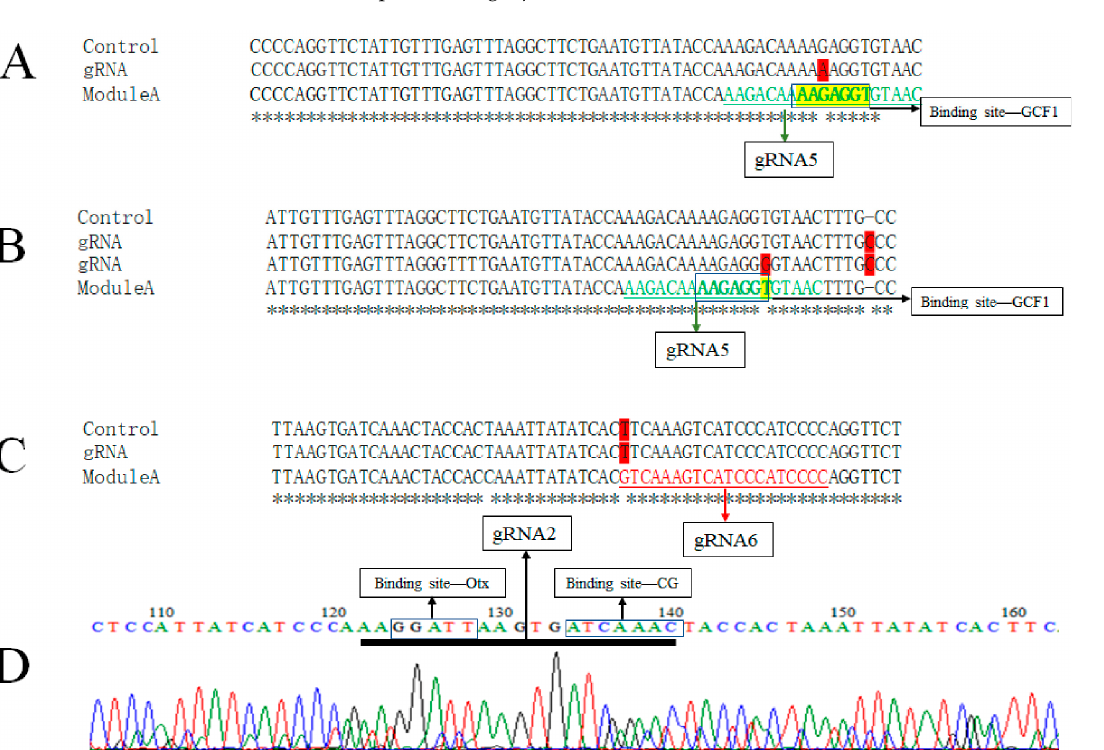
Figure 5. Point mutations, insertion and mosaicism of embryos revealed by sequencing. ( A ) Sanger sequencing from one embryo reveals a point mutation in the gRNA5 target sequence. ( B ) Sanger sequencing from two embryos reveals a point mutation in the gRNA5 target sequence and an insertion near the transcription factor binding sites. ( C ) A mismatched base is found in gRNA6. ( D ) TIDE analysis of PCR products from one embryo reveals mosaicism. Green text indicates the target sequence of gRNA. The boxed region indicates the transcription factor biding site. Text highlighted in red indicates the point mutation. “Control” indicates the sequence from control embryos. “gRNA” indicates the sequence from embryos injected with gRNA. “Module A” indicates the sequence used for gRNA design. Asterisk indicates the same nucleotide site. Sequences underlined in black in ( D ) indicate the target sequence of gRNA2.